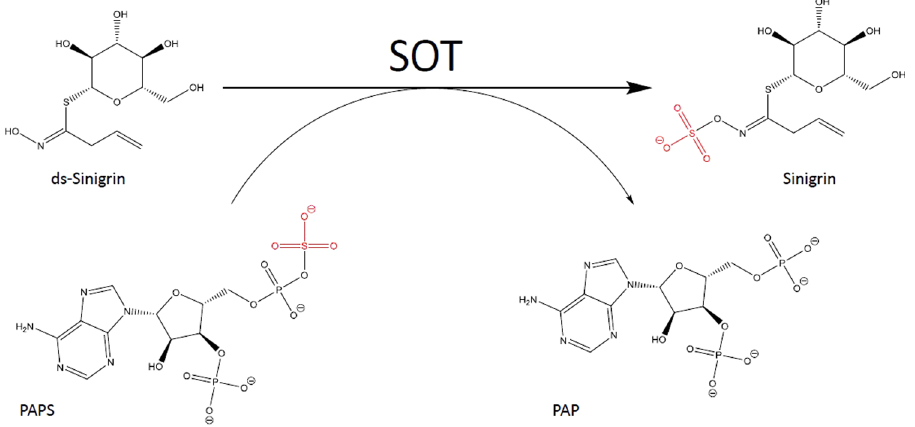
Figure 1. AtSOT18 catalysed reaction. The red coloured sulphate ester with carbon-oxygen-sulphur bonding (R-O-S-O